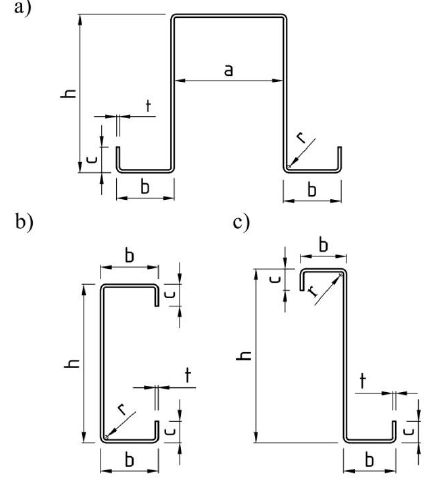
Figure 3: View of cold-formed non stiffened cross-section: a) hat